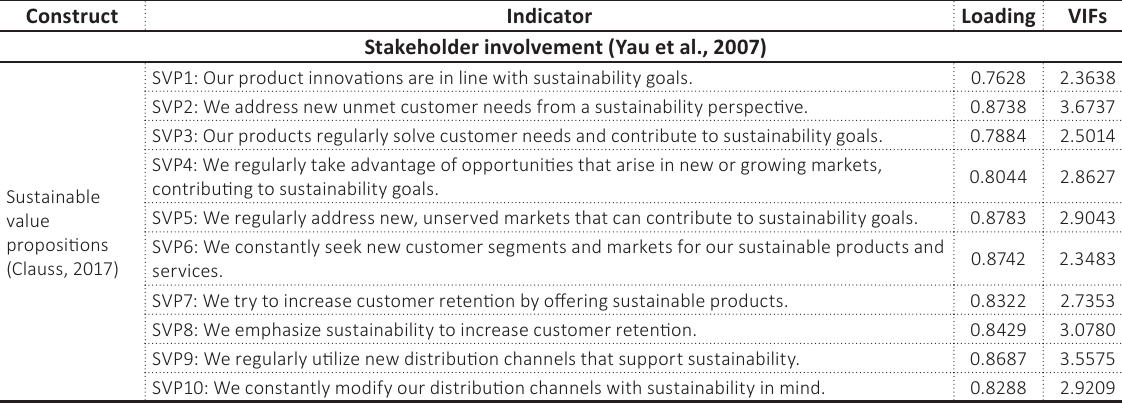
Table 3 (cont.). Constructs, indicators, loadings, and variance inflation factor